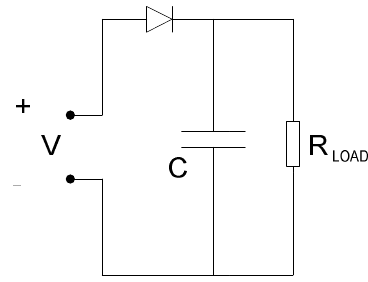
Figure 11. Half bridge rectifying circuit. This is the most economical structure, able to use only the positive part of the